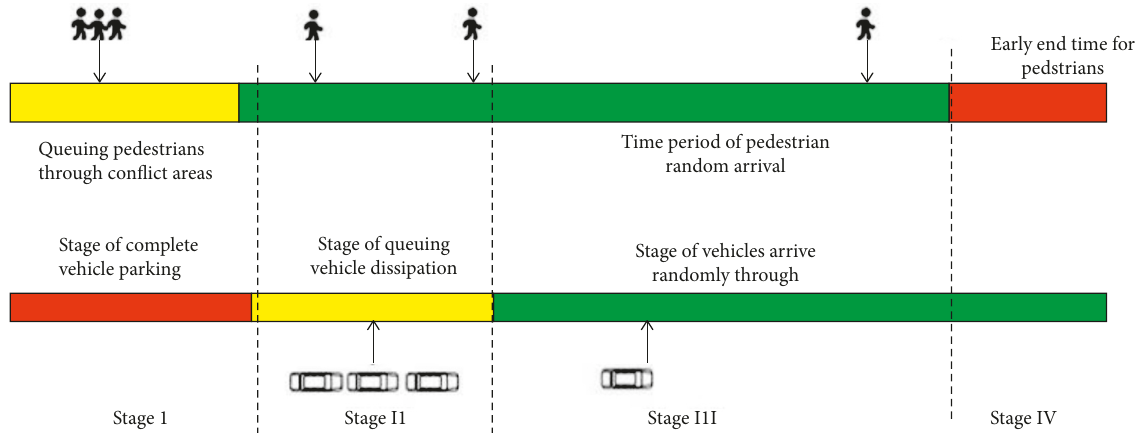
Figure 3: Signal phase stage in different traffic and pedestrian